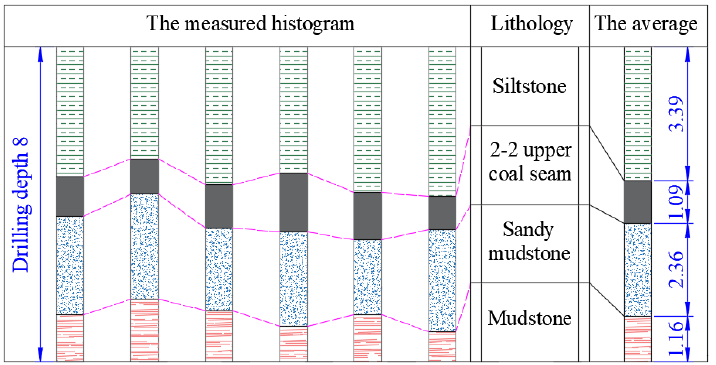
Figure 4. Detection results of the MEWC roof structure (m).